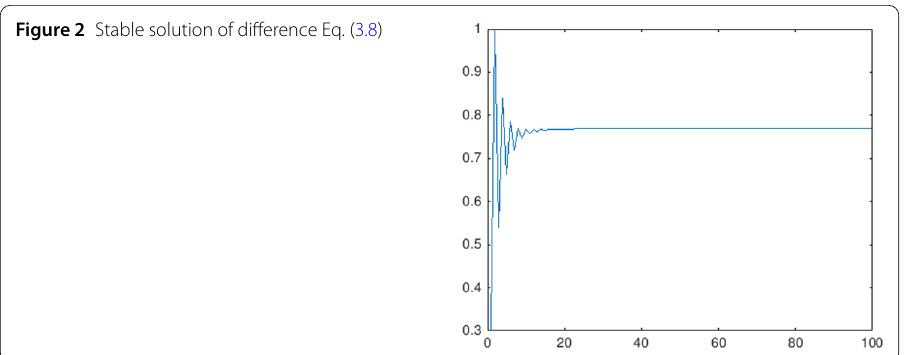
Figure 2 Stable solution of difference Eq.